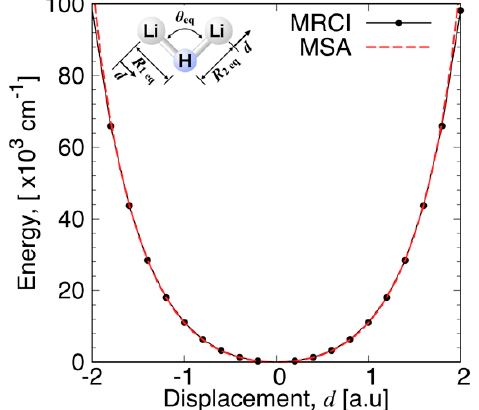
Figure 6. Potential energy curve for the antisymmetric stretch of Li 2 H at the equilibrium angle.